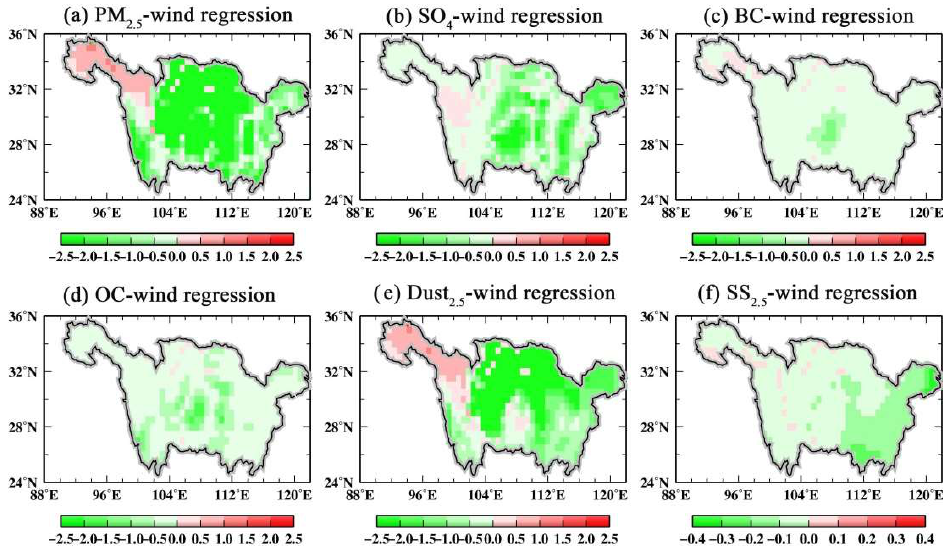
Figure 12. Multiple linear regression coefficients ( β 1 ) of each PM 2.5 component with surface wind speed (Wind), in units of µg m −3 m −1 s. Figure 12 (a), (b), (c), (d), (e) and (f) refer to the regression coefficients of PM 2.5 , SO 4 , BC, OC, Dust 2.5 and SS 2.5 with surface wind speed,